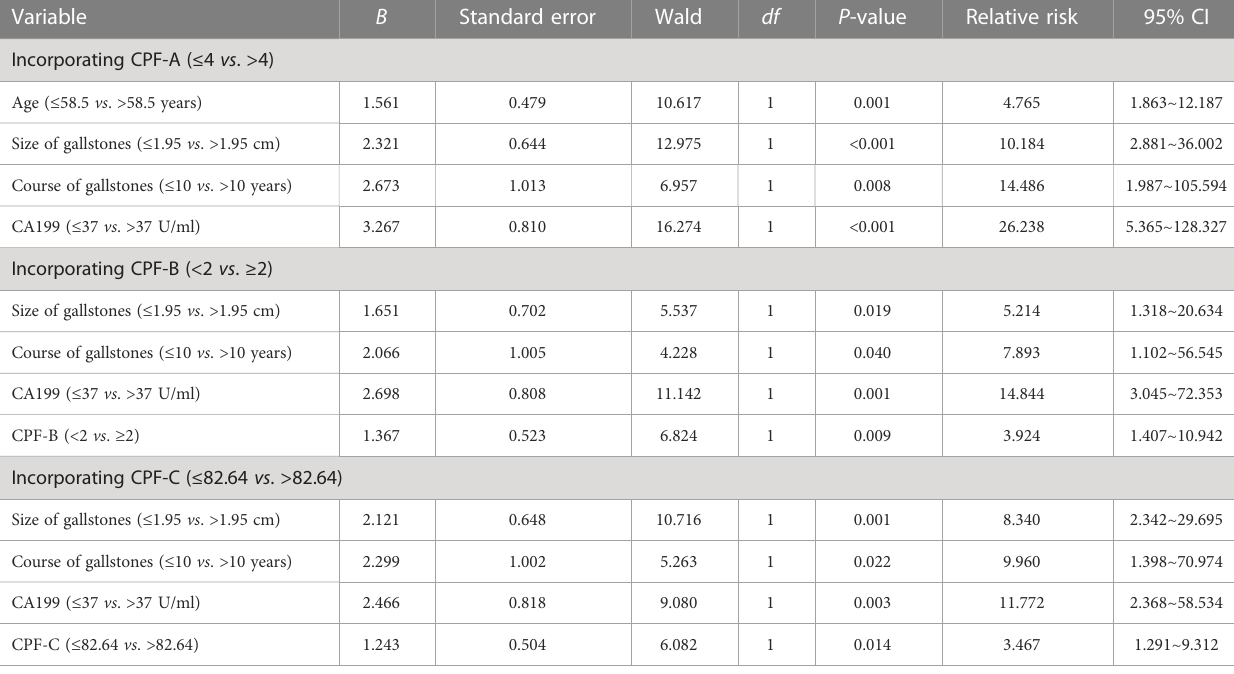
TABLE 6 Multivariate analysis of the risk factors associated with GBC in patients with gallstones in the external validation samples. Variable B